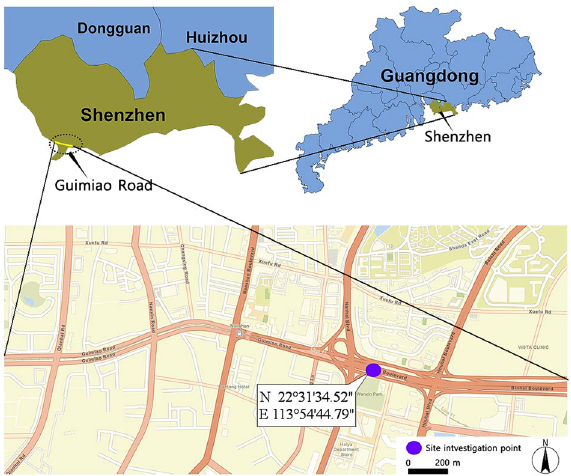
Figure 1. Sampling location in Shenzhen, China. This figure was created with ArcGIS Online (https:// www. arcgis. com/ apps/ mapvi ewer/ index. html) and Pixel Map (http:// pixel map. amcha rts.